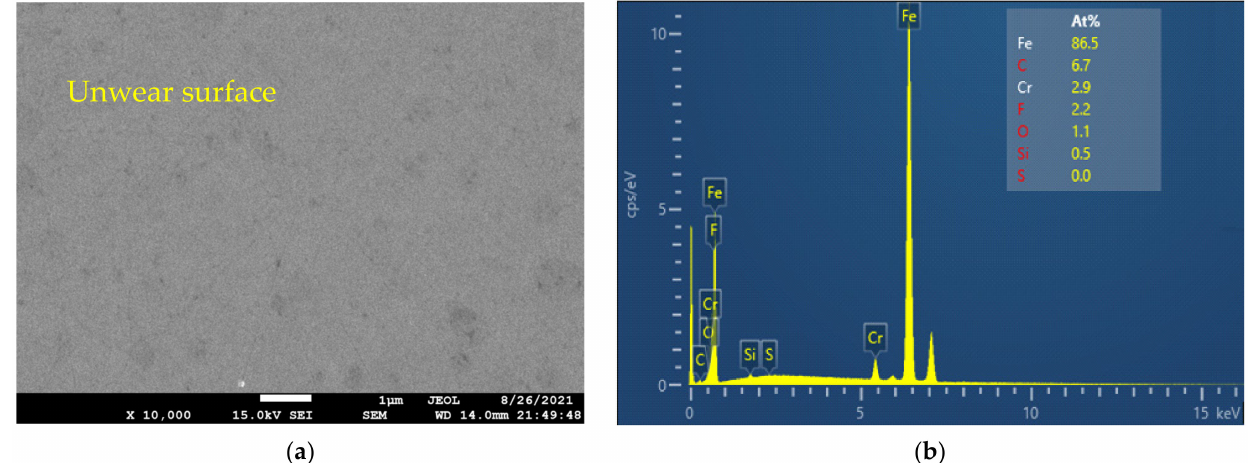
Figure 8. ( a ) SEM image and ( b ) EDX analysis of the unwear surface on the disc. SEM/EDX surface analysis of the rubbed surfaces on discs from the tests lubricated with the IL and different concentrations of CuO and ZnO nano-oxides are shown in Figure 9. The chemical composition of worm surfaces on the disc was analyzed at two different points, defects, and scratches. The survey spectra and the weight percentages of chemical compositions on the defects are represented by the figures on the right side of the corresponding SEM images. The distribution of chemical components on the scratch line for all tested lubricants is summarized in Table 4.